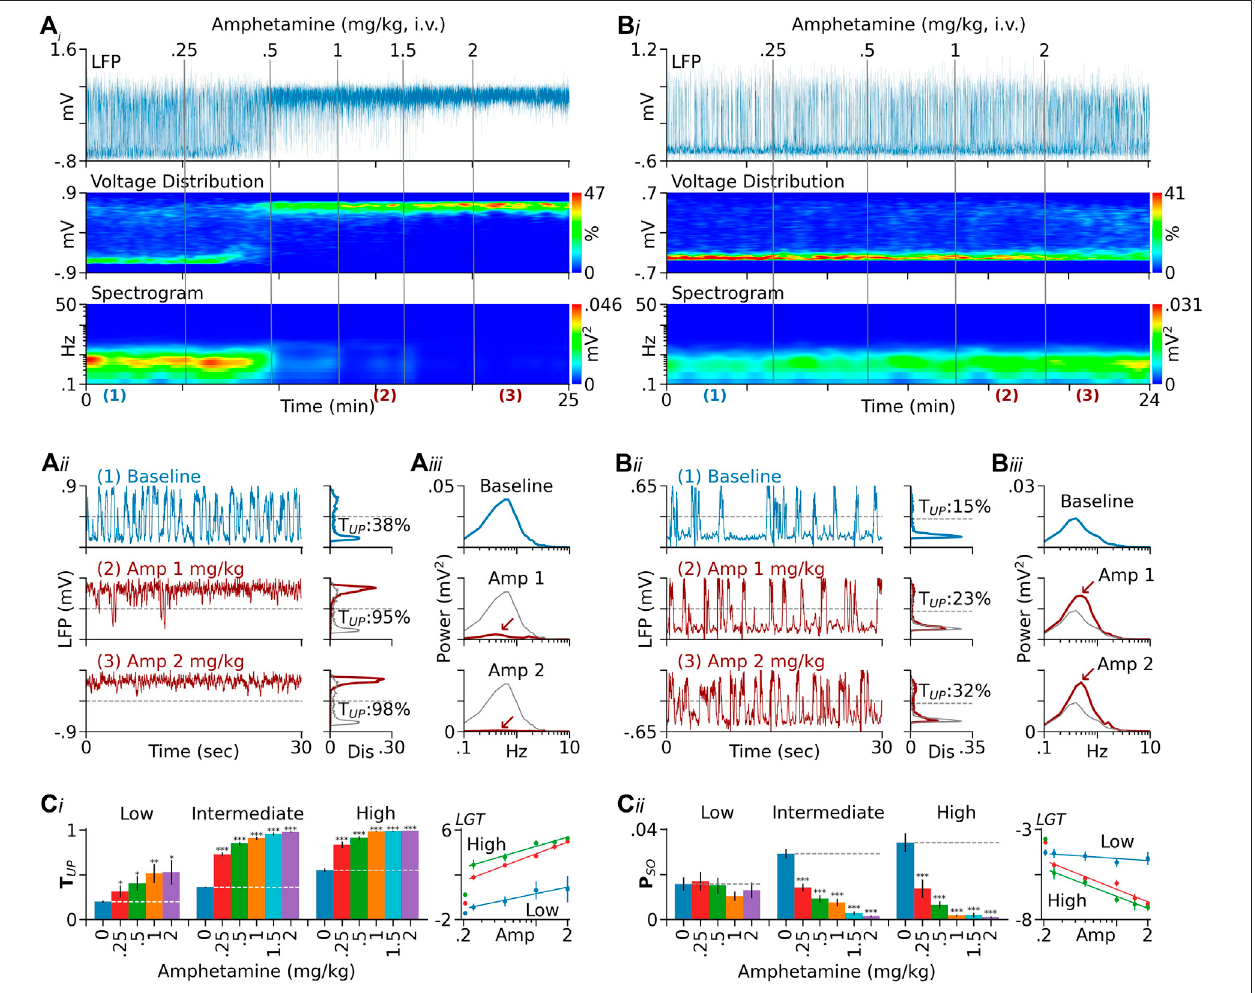
FIGURE 1 | Dependence of D -amphetamine ’ s effect on baseline T UP . (Ai) Results from a rat showing changes induced by D -amphetamine in PFC LFPs (top), LFP voltage distribution (middle), and spectrogram (bottom). In this and following fi gures, the sign of LFPs is reversed so that upward de fl ections represent transitions to Up states. Theverticallinesindicatethetimes ofdruginjection. The numbers abovethelines arecumulativedoses(mg/kg). (Aii) Lefttraces aresegments ofLFPs displayed onanexpandedtimescale.Chartsontherightaredistributionhistogramsof2-minLFPrecordingsselectedduringbaselineandafter D -amphetamineinjection.The locations of the selected recordings are indicated by the numbers below the spectrogram in (Ai) . For comparison, the baseline histogram is also shown in grey in histograms obtained after D -amphetamine. In this rat, D -amphetamine increased T UP (the percentage of time in Up states) from 38 to 95% and then to 98% after 1 and 2 mg/kg, respectively. (Aiii) Autospectra of the same 2-min LFP recordings. The major spectral peak seen during baseline (upper chart) con fi rms the presence of Up/ Down oscillations. The peak was almost completely suppressed after 2 mg/kg of D -amphetamine (red arrow). (Bi – Biii) Results from another rat showing that D -amphetamine was less effective in promoting the Up state in this rat compared to Rat A. This rat also had a low baseline T UP (15%) relative to that of Rat A (38%). (Ci) Summary of data from 126 rats tested with D -amphetamine. They were divided into three groups based on baseline T UP (low: < 25%, intermediate: 25 – 45%, and high: > 45%).While D -amphetamineincreasedT fi cantlydownshiftedinthelow-baselinegroup(right). (Cii) D -Amphetamine UP inallgroups(left),itsdose-responsecurveissigni had no signi fi cant effect on P SO (the absolute mean power between 0.3 and 1.5 Hz) in the low-baseline group, but it signi fi cantly inhibited P SO in both the intermediate and high-baseline groups (left). The dose-response curve of D -amphetamine is signi fi cantly upshifted in the low-baseline group relative to those in the intermediate and high-baselinegroups (right,see Results for detailed statistics). Inboth (Ci) and (Cii) , the y -axis valuesindose-response curves are logit-transformed(LGT). Thelines are logarithmic fi ts to the means. The leftmost points are baseline values. * p < 0.05, ** p < 0.01, *** p < 0.001 compared to baseline (blue bars).